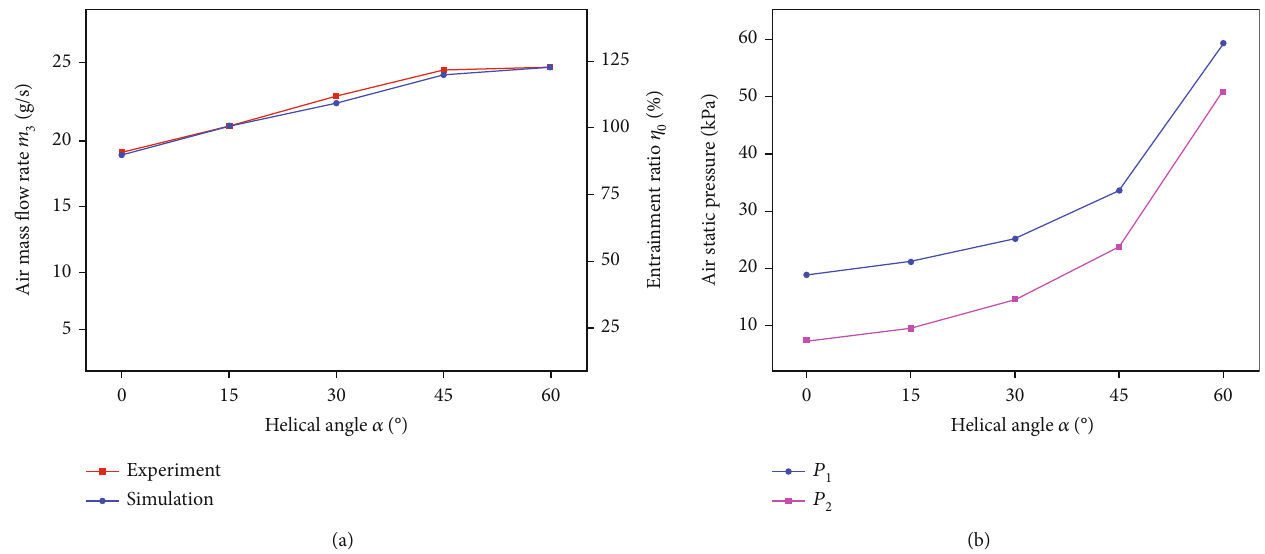
Figure 8: Relationship between helical angle and entrainment performance of drill bit without fl ushing nozzles: (a) entrainment performance; (b) static pressure.